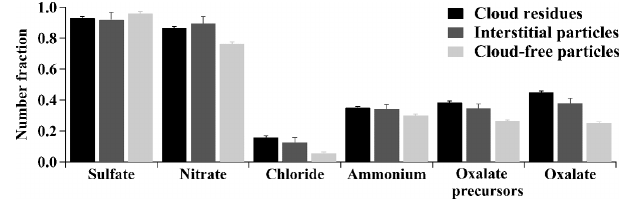
Figure 3. Comparison in number fractions of sulfate ( m/z − 97), nitrate ( m/z − 46 or − 62), chloride ( m/z − 35 or − 37), ammonium ( m/z 18), oxalate precursors ( m/z − 59, − 71, − 73, − 87, − 103, or − 117), and oxalate ( m/z − 89) between the Fe-containing cloud residues, interstitial particles, and cloud-free particles.